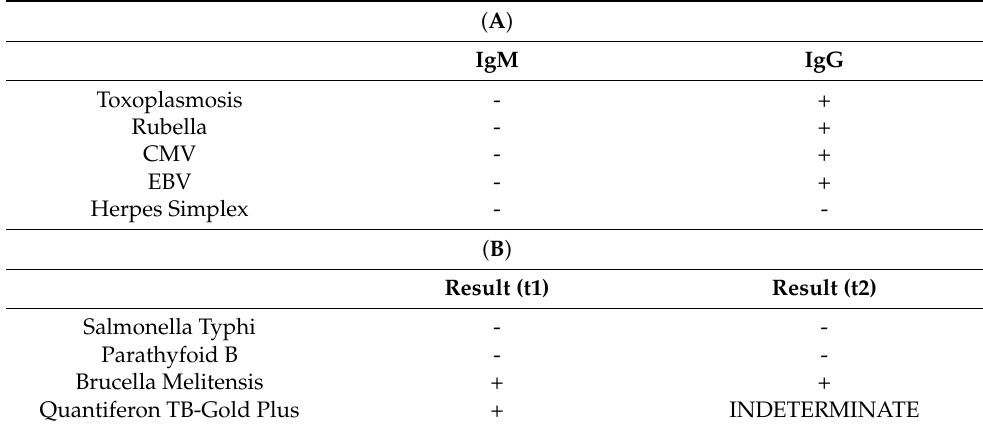
Table 2. ( A ) Antibody profile of the main infectious diseases (Abbreviations: EBV: Epstein–Barr Virus, CMV: Cytomegalovirus, IgM: Immunoglobulin M, IgG: Immunoglobulin G). ( B ) Antibody profile of the main infectious